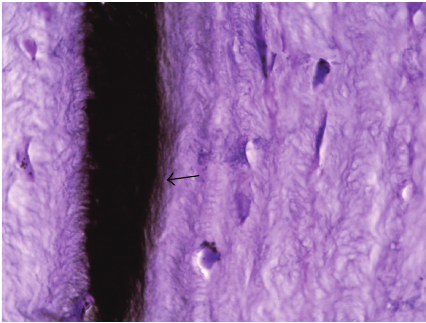
Figure 9: A photomicrograph of rabbit cornea group II, showing minimal diffusion of the black pigment at the adjacent corneal stroma (arrow). H&E × 400.